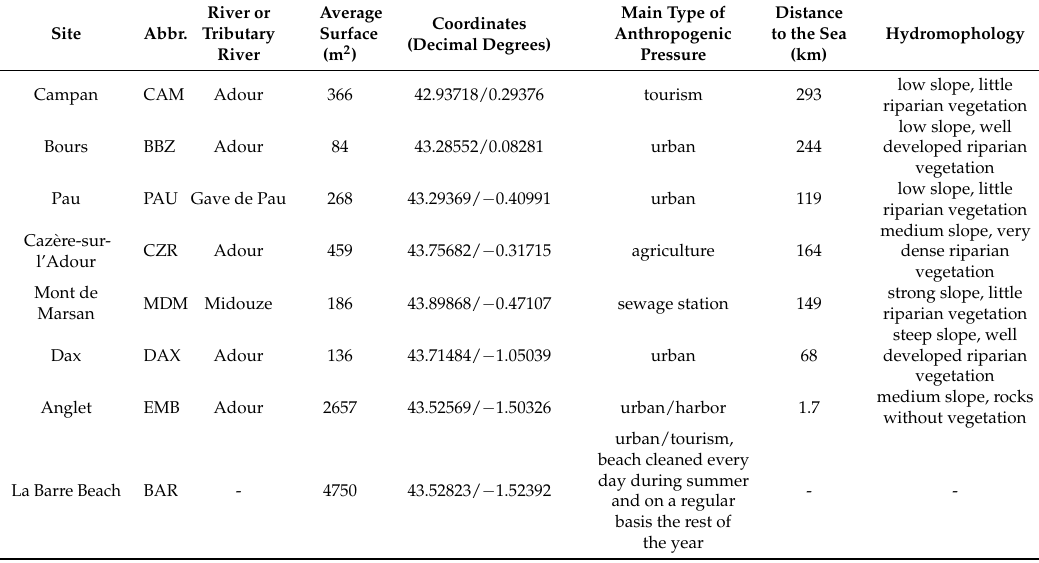
Figure 1. Localization of sampling sites. Table 1. Study sites characteristics.